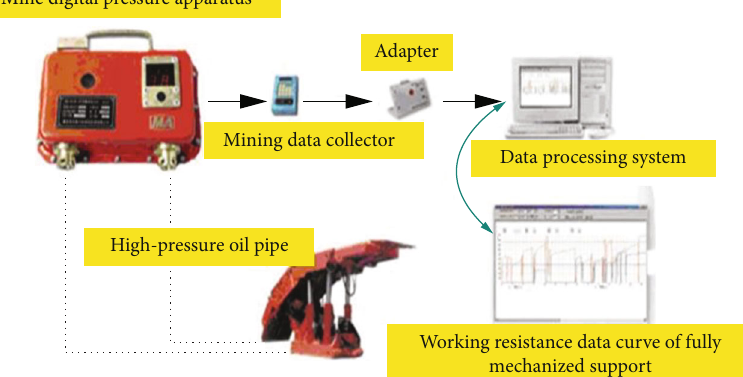
Figure 14: Continuous monitoring system for fully mechanized mining support working resistance.